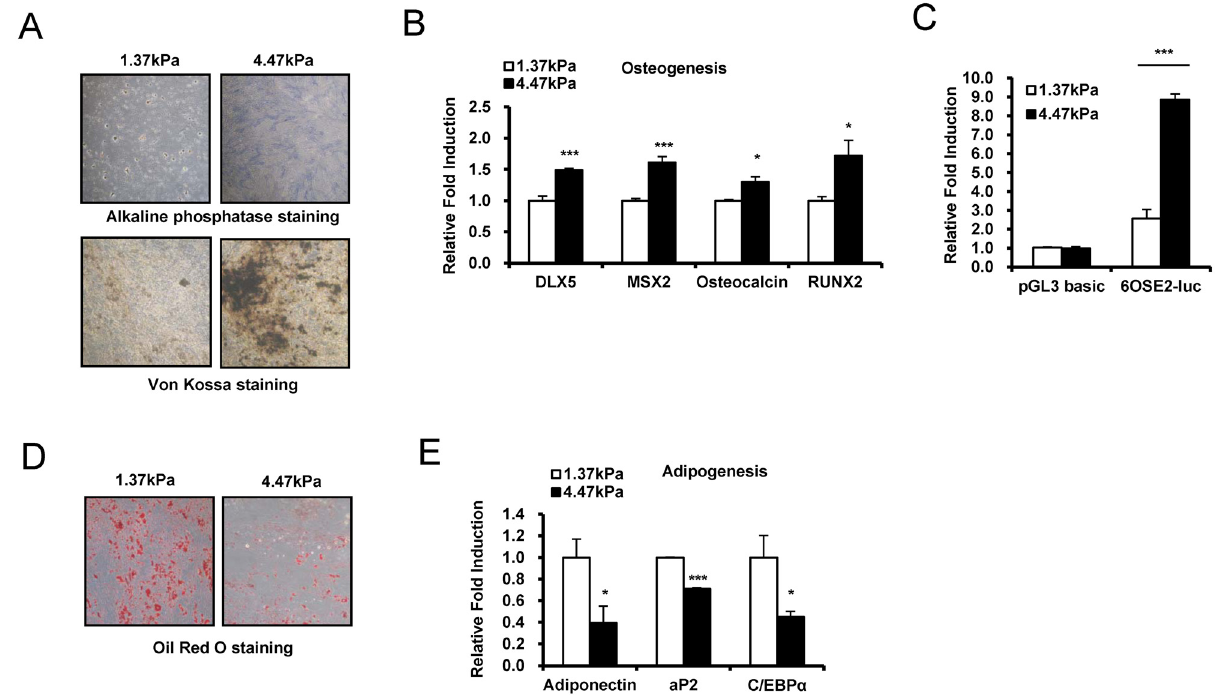
Fig 2. ECM stiffness stimulates osteoblast differentiation and represses adipocyte differentiation. (A) A stiff hydrogel stimulates osteogenic differentiation. hMSCs were seeded on a 1.37 or 4.47 kPa hydrogel, and osteogenic differentiation was induced 24 h after seeding. Cells were stained for alkaline phosphatase at 9 days after differentiation and Von Kossa staining was assessed to see mineralization at 21 days after differentiation. (B) qRT-PCR analysis of the osteoblast marker genes DLX5 , MSX2 , osteocalcin, and RUNX2 of the cells used in panel (A). Expression of the marker genes was normalized to GAPDH expression. Data are presented as fold induction. ( * p < 0.05, *** p < 0.005, t-test) (C) The luciferase reporter gene construct 6OSE2-luc was introduced into hMSCs along with a Runx2-expressing vector, which provides similar amounts of Runx2 protein in assay condition. After 16 h, the transfected cells were plated on a 1.37 or 4.47 kPa hydrogel. After 24 h, luciferase reporter gene activity was analyzed. The pGL3-basic luciferase reporter gene construct, which has no promoter for transcription, was used as a negative control. A Renilla luciferase-expressing vector was used as a transfection control. Luciferase activity was normalized to Renilla luciferase activity and is expressed as relative fold induction. ( *** p < 0.005, t-test) (D) hMSCs were seeded on a 1.37 or 4.47 kPa hydrogel, and adipogenic differentiation was induced 24 h after seeding. Oil Red O staining was assessed to see lipid droplet at 9 days after differentiation (E) The expression of the adipogenic marker genes adiponectin, aP2 , and C/EBP α were analyzed by qRT-PCR in adipocyte-differentiated hMSCs. Adipogenic differentiation was assessed according to the protocol described in the Materials and Methods. Target gene expression was normalized to GAPDH . Data are expressed as relative fold induction. ( * p < 0.05, *** p < 0.005,